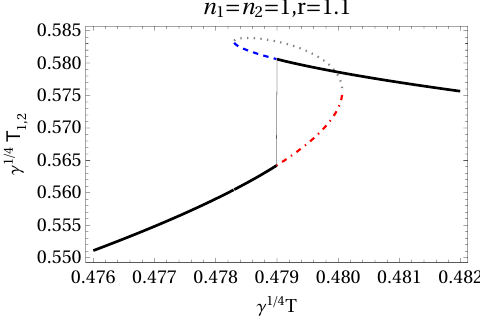
Figure 6 . The behavior of the e(cid:11)ective temperature of the subsystems during the (cid:12)rst-order phase transition with n 1 = n 2 = 1 and r = 1 : 1. The dotted line in the entropy curve indicates the jump in the e(cid:11)ective temperature when there is no supercooling or